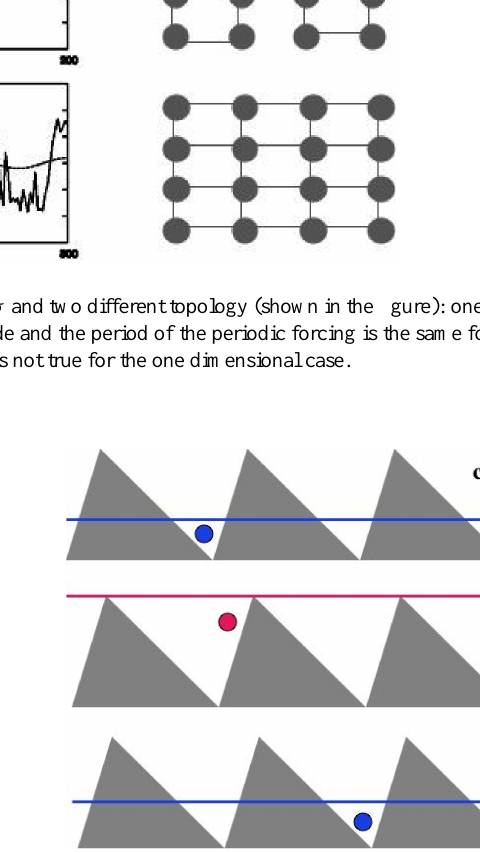
Fig. 9. A simple model of Brownian motor. Going from the top to the bottom of when the temperature is low (cold) a particle moving in the ratchet potential is trapped in one of the minima. Rising the temperature, the particle becomes almost free to move and, because its initial condition (minimum) is close the maximum on its right, the particle has more probability to go towards the right minimum. If the temperature is now decreased the particle has more probability to be trapped in the right minimum with respect being trapped in the minimum on the